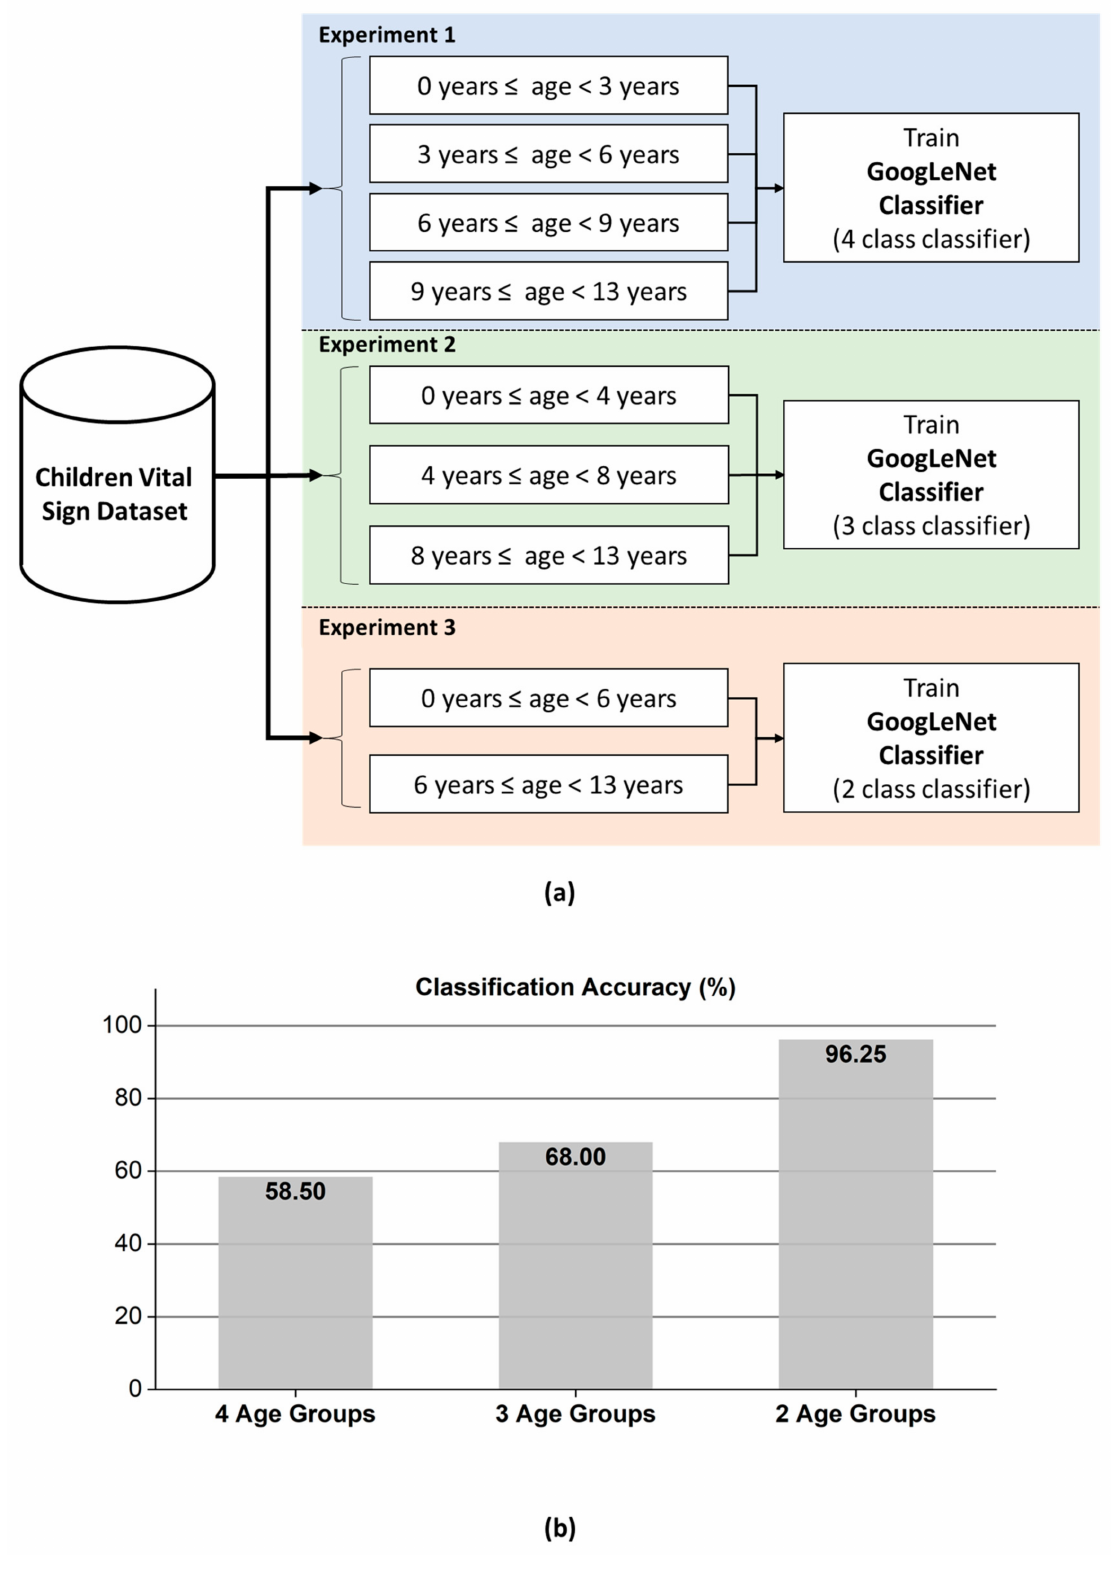
Figure 7. ( a ) Age-group classification experiments performed with GoogLeNet. Upper: age prediction based on four, three, and two age groups and ( b ) bar chart showing the increase in prediction accuracy with a decreased number of